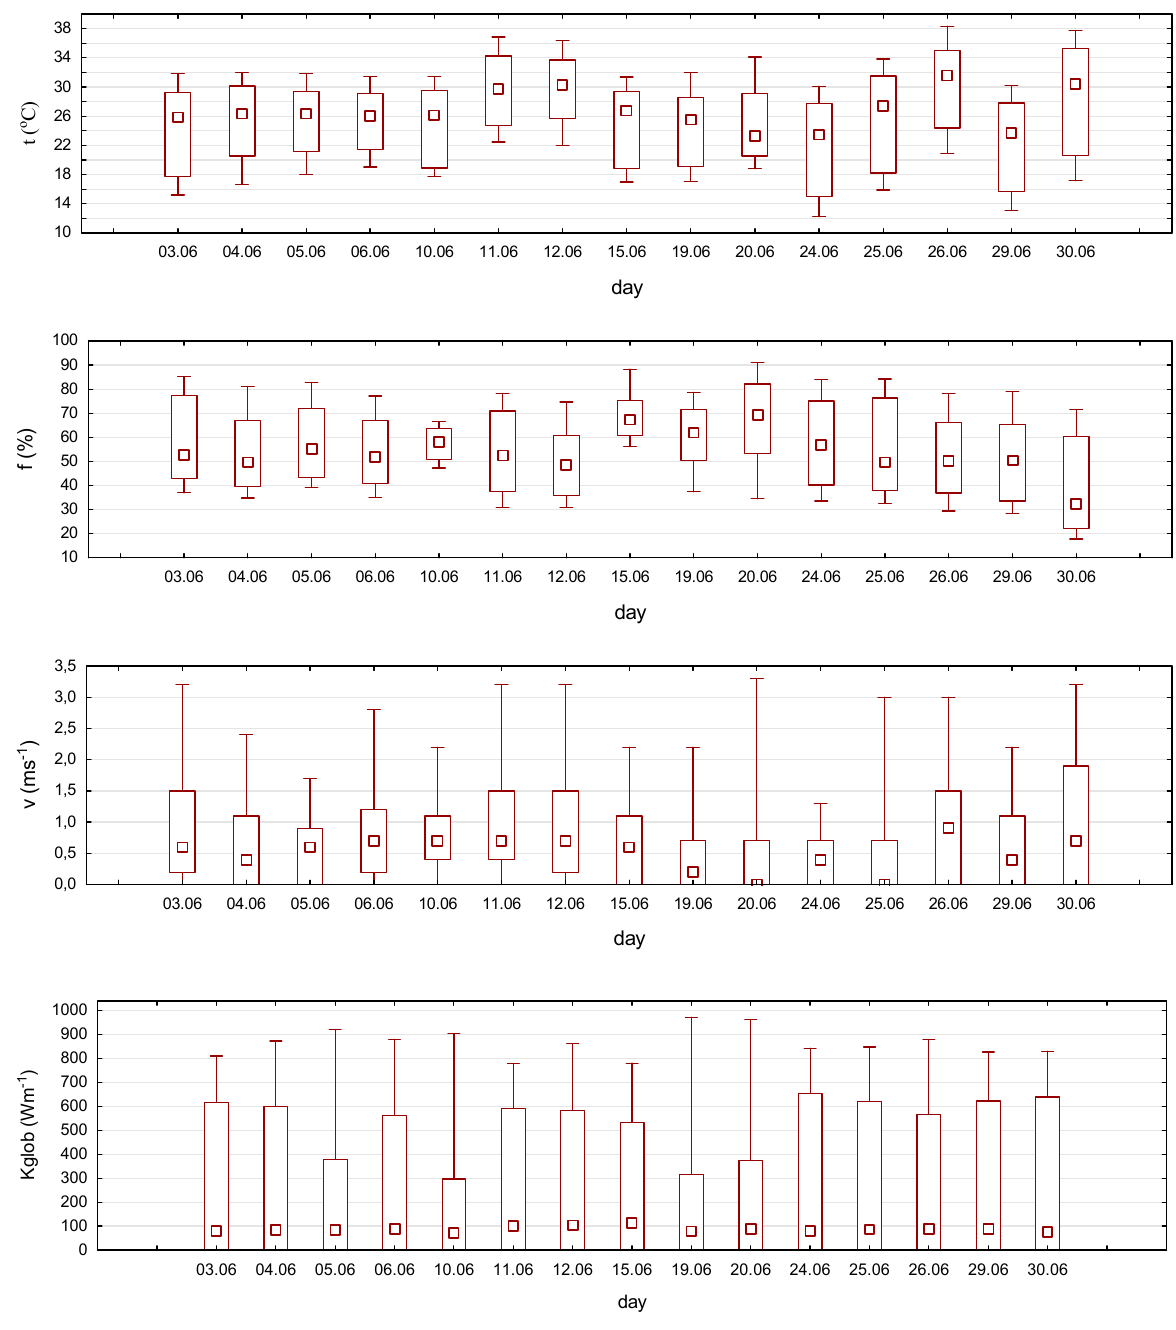
Figure 3. Median, lower and upper quartiles, as well as the maximum and minimum air temperature, relative humidity, wind speed, air pressure, and solar radiation intensity in Bydgoszcz on hot days in June 2019. The maximum diurnal air temperature was most frequently recorded around 4:00 p.m., and the minimum was recorded usually several minutes to 5:00 a.m. (Figure 4). Mean diurnal values of the Universal Thermal Climate Index led to a conclusion that normally “moderate heat stress” occurred (Table 5). The extreme values ranged from 11.6 °C to 42.8 °C, falling within categories from “no thermal stress” to “very strong heat stress”. Maximum diurnal values pointed to at least “strong heat stress”, and on five days suggested “very strong heat stress” (Figure 5).